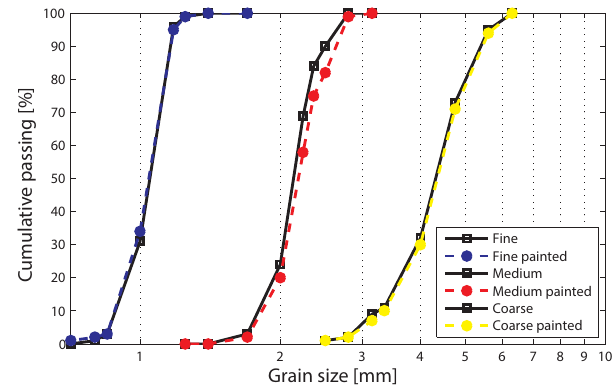
Figure 2. Grain-size distribution of the original sediment (black lines) and the coloured sediment (blue, red and yellow